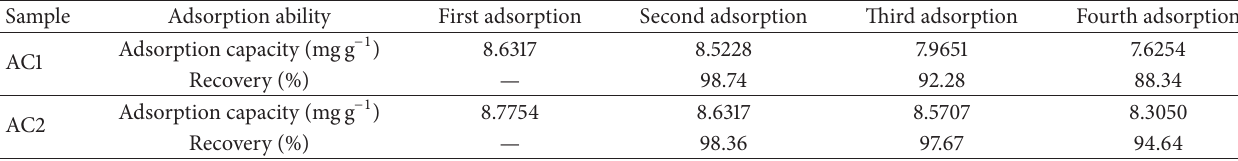
Table 5: Adsorption-desorption cycles of methylene